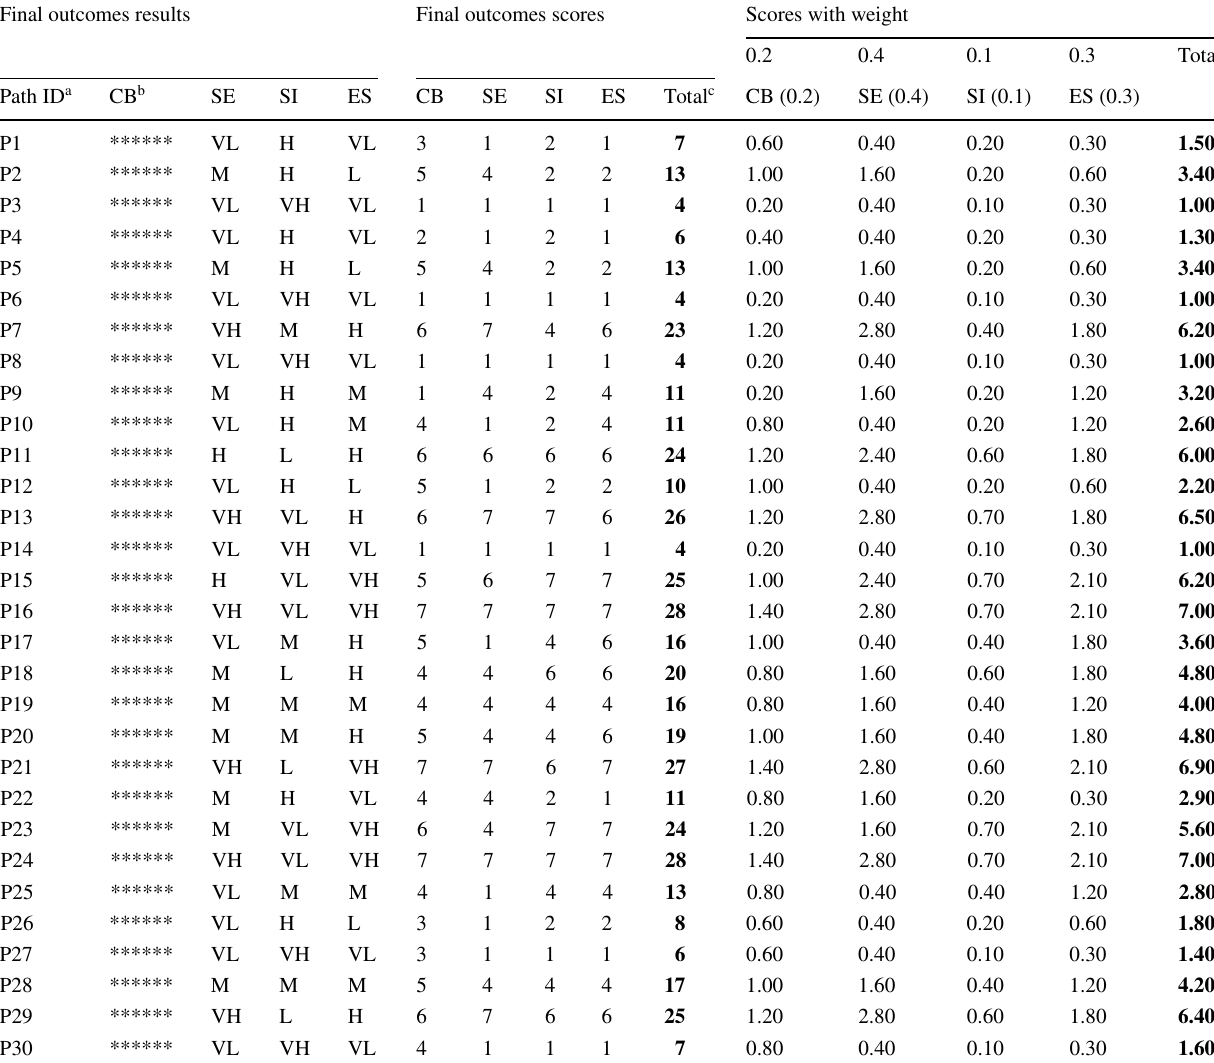
Table 9 Accumulating and normalizing the outcomes with weight